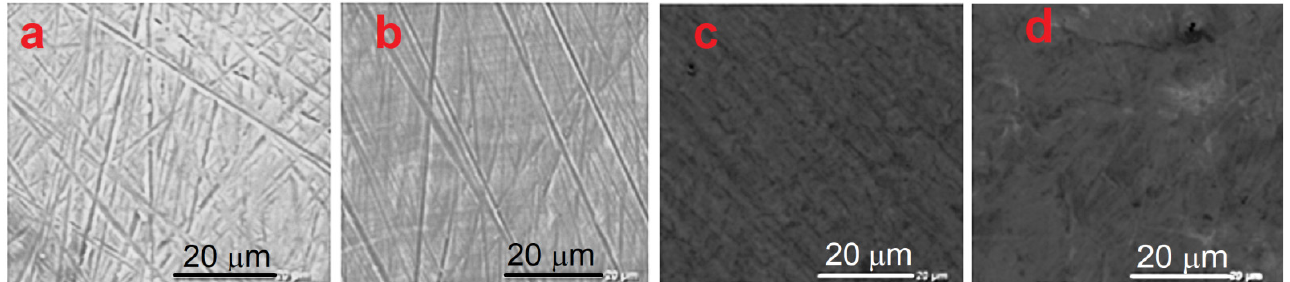
Figure 2. The SEM-images of the 321 steel surfaces: as-received ( a ), as well as after HIPIB irradiation at the energy densities of ( b ) 0.6, ( c ) 1.0, and ( d ) 2.0 J/cm 2. .